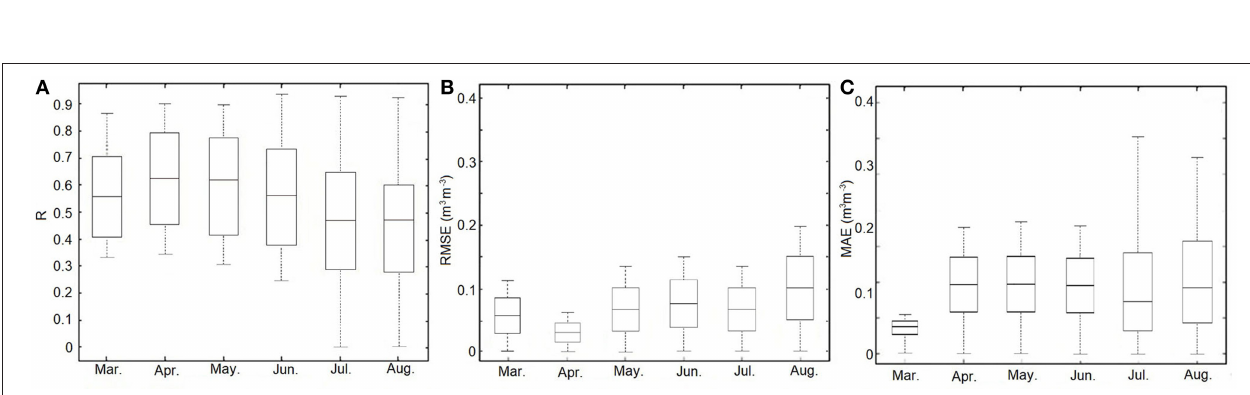
Frontiers in Big Data |